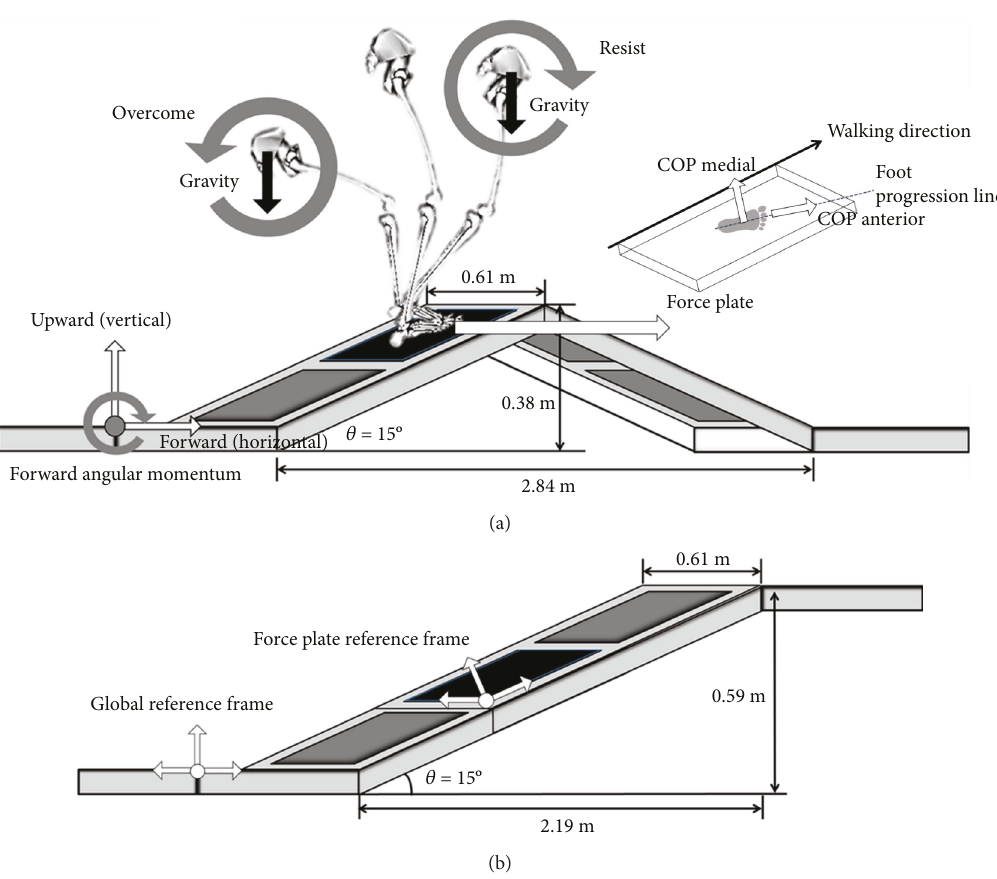
Figure 1: Custom-made slope walkway in a diagonal view. (a) Illustration of the lower extremity during walking at the up-down transition on a triangle-shaped slope. When the body ’ s center of mass (COM) is behind the center of pressure (COP) at an early stance phase, the gravitational force generates a backward angular momentum. To prevent backward falls, the backward angular momentum must be resisted. When the body ’ s COM is ahead of the COP at a late stance phase, the gravitational force generates a forward angular momentum. To prevent forward falls, the forward angular momentum must be resisted. The anterior-posterior axis of the COP is coincident with the longitudinal axis of the foot progression line. The medial-lateral axis of the COP is perpendicular to the anterior- posterior axis of the COP. (b) Continuous uphill walkway. To recalculate the measurements of the 3 axes of the ground reaction force, a global reference frame was established on the ground, and the force plate had its own local reference